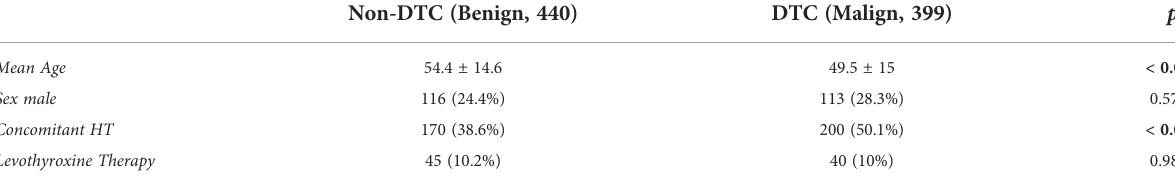
TABLE 1 Univariate analysis between DTC and non-DTC patients.